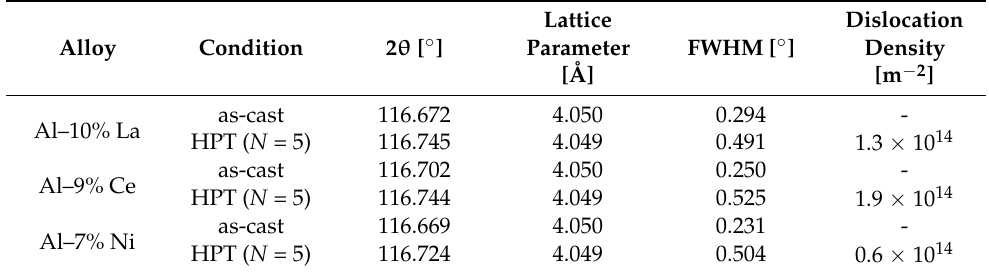
Table 1. Results of X-ray studies of the eutectic aluminum